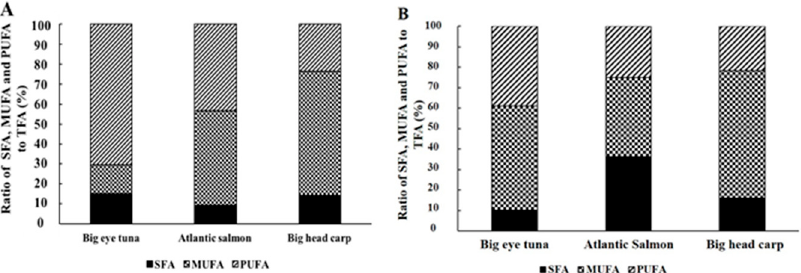
Figure 1. Ratio of SFA, MUFA, PUFA to TFA. ( A ) Total lipids, ( B ) TG fraction of the three kinds of fish heads.